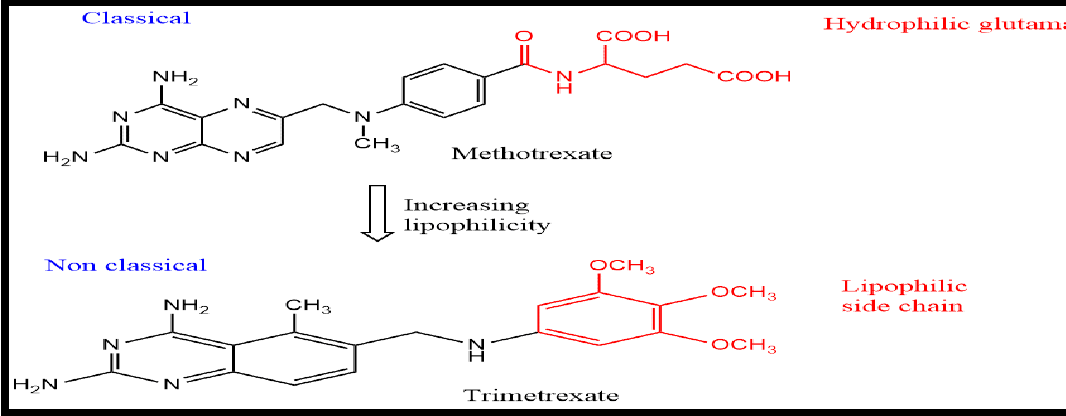
Figure 1. Classification of antifolate